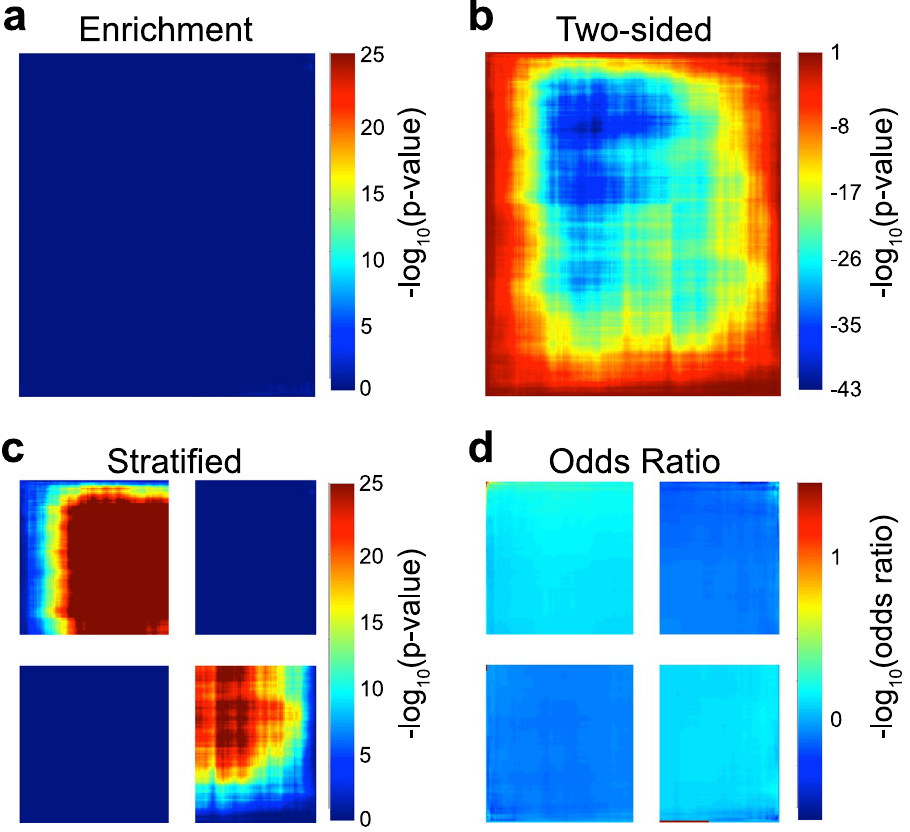
Figure 6. Heatmaps for each RRHO method using real data. ( a ) Enrichment; ( b ) Two-sided; ( c ) Stratified; and ( d ) Log Odds Ratio RRHO